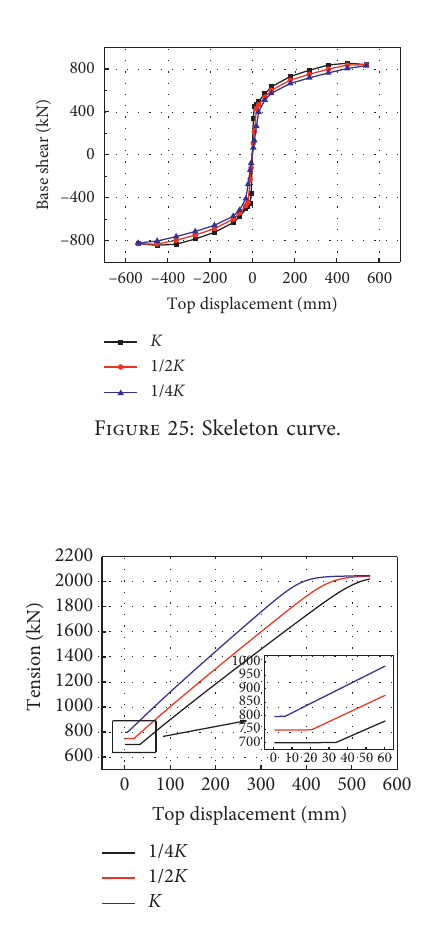
Figure 26: Prestressed tendon axial force-top displacement